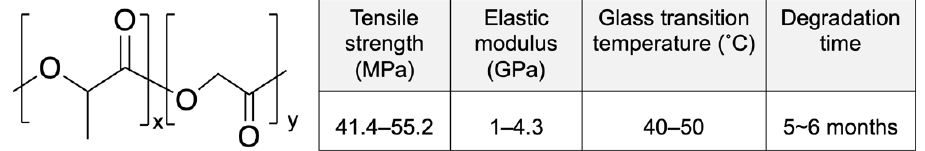
Figure 7. Structure and properties of poly(lactic- co -glycolic acid) (PLGA) (x-85L:y-15G). Adapted